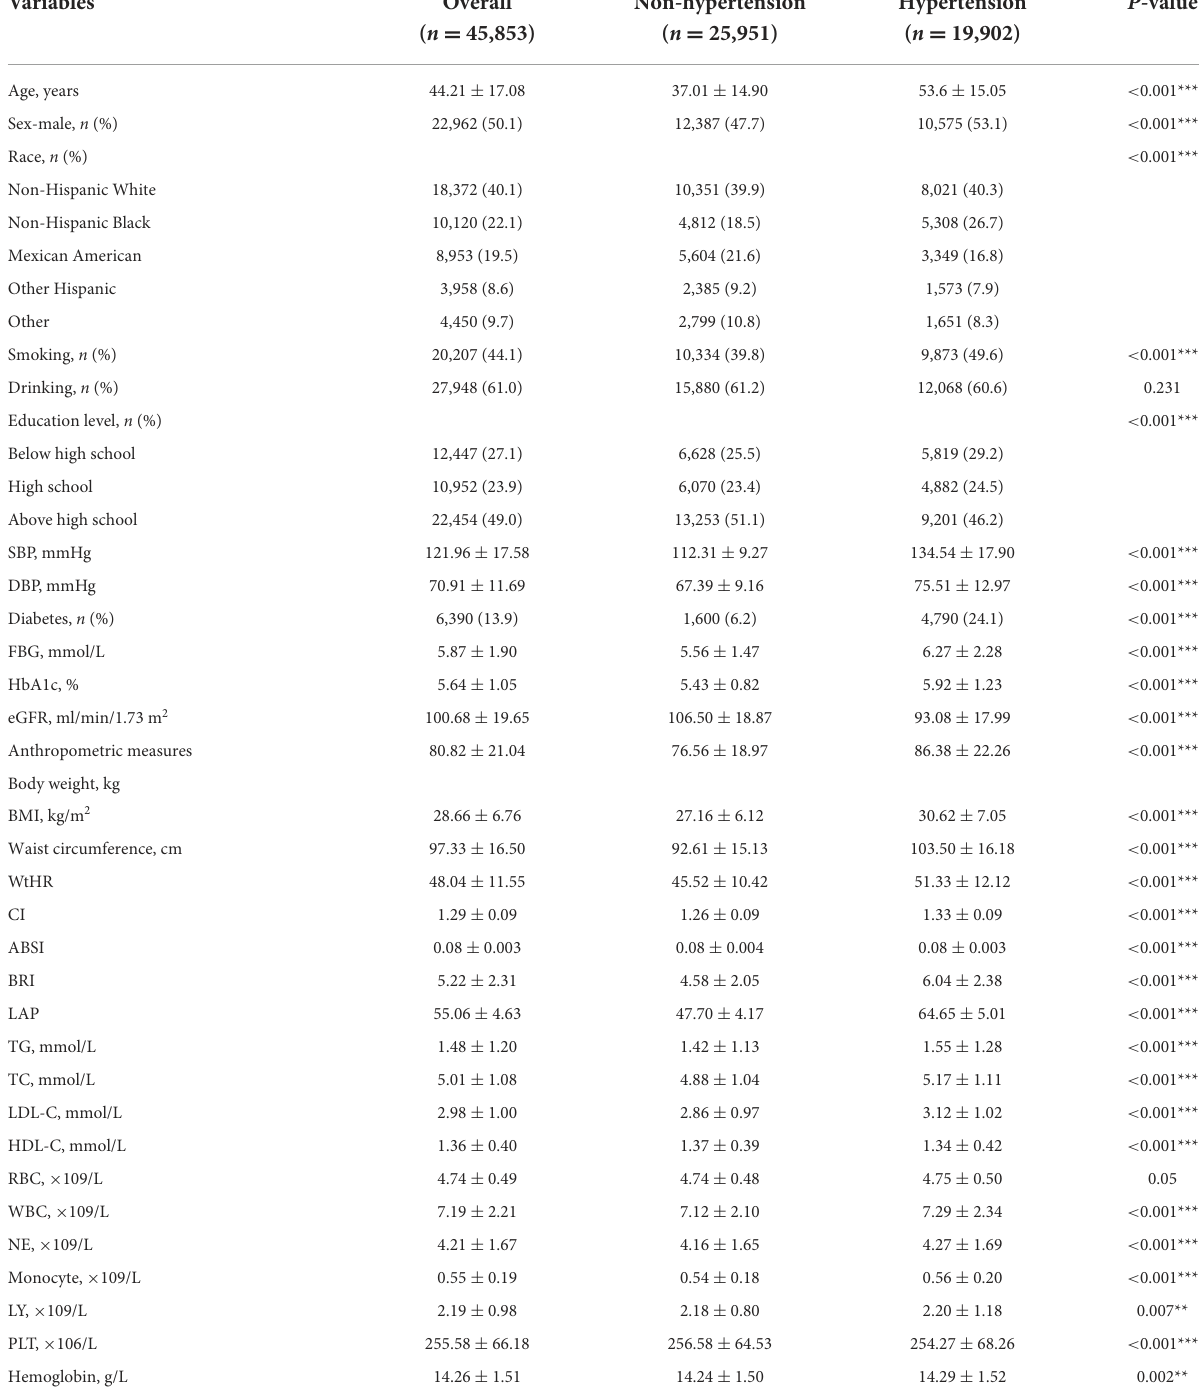
TABLE 1 Baseline